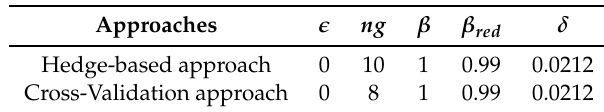
Table 2. Best hyper-parameter configurations have been found by the Hedge and the cross-validation algorithms.